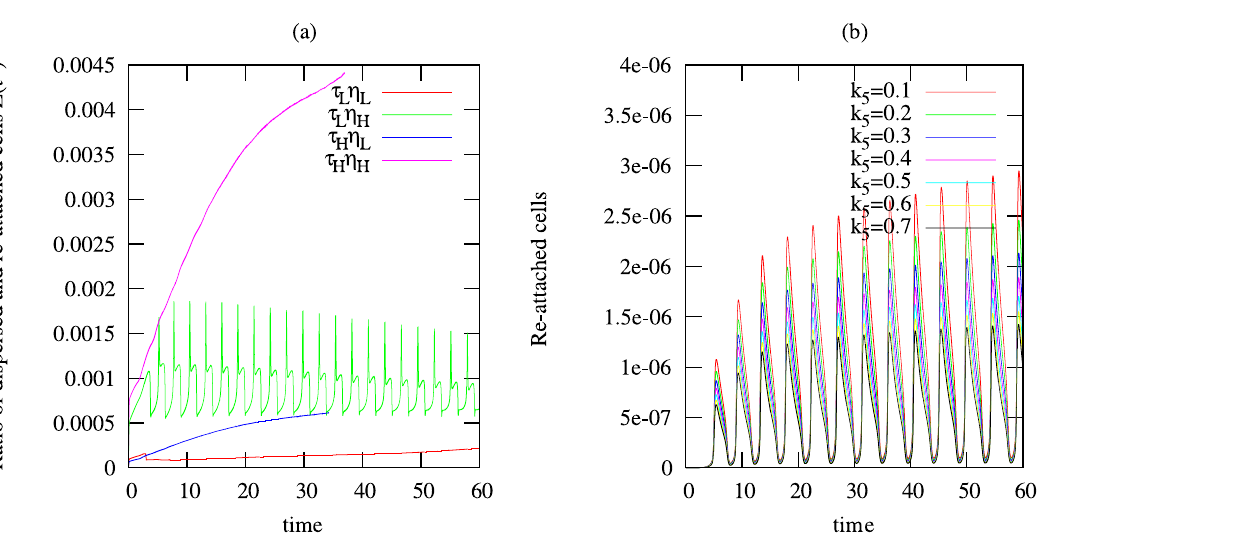
Fig 4. Temporal plots of results for constant dispersal with no influence of quorum sensing using dispersal rates η 1 = 2.4 d − 1 , compared to quorum sensing induced dispersal with τ = 50 nM . Shown are (a) the total amount of biomass in the biofilm M tot , (b)the amount of suspended biomass that leaves the biofilm P ( T ).